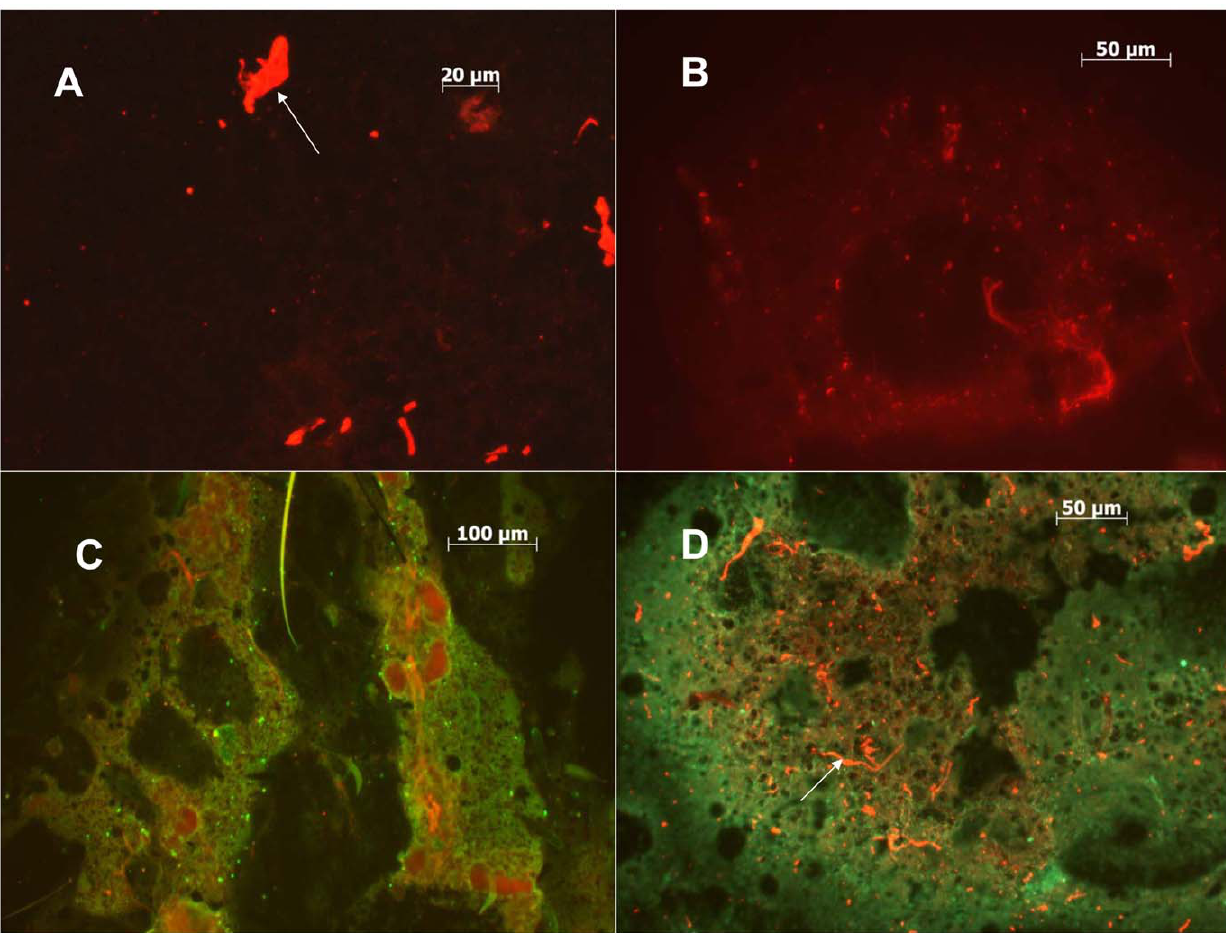
Figure 8. Localization of CxFV Izabal and WNV to head tissues in co-infected mosquitoes. A) Uninfected head tissues of Cx. quinquefasciatus stained with AlexaFluor 594 (red). White arrow depicts non-specific staining of debris. B) Head tissues of CxFV Izabal-infected Cx. quinquefasciatus , harvested 7 DPI. CxFV Izabal stained with AlexaFluor 594. C) Head tissues of WNV-infected Cx. quinquefasciatus , harvested 9 DPI. WNV stained with AlexaFluor 488 (green). D) Co-infected head tissues of Cx. quinquefasciatus . Mosquito inoculated simultaneously with CxFV Izabal and WNV, harvested 9 DPI. CxFV Izabal stained with AlexaFluor 594 (red) and WNV with Alexa 488 (green). White arrow denotes non-specific staining of debris.